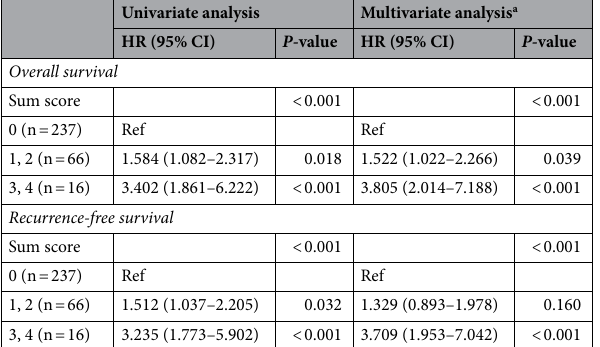
Table 2. Univariate and multivariate Cox regression analyses for overall survival and recurrence-free survival. a Cox proportional hazards regression model, adjusted for tumor subsite, Lauren histology, lymphatic emboli, venous invasion, perineural invasion, T category, N category, and M category (Supplementary Tables 4 &